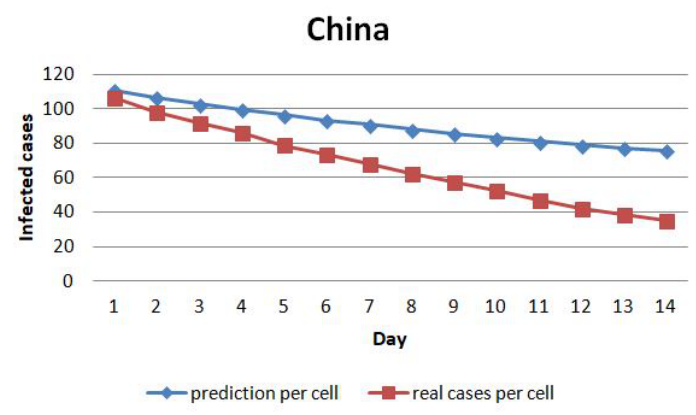
Figure 13. The average of the cases prediction per cell in China.